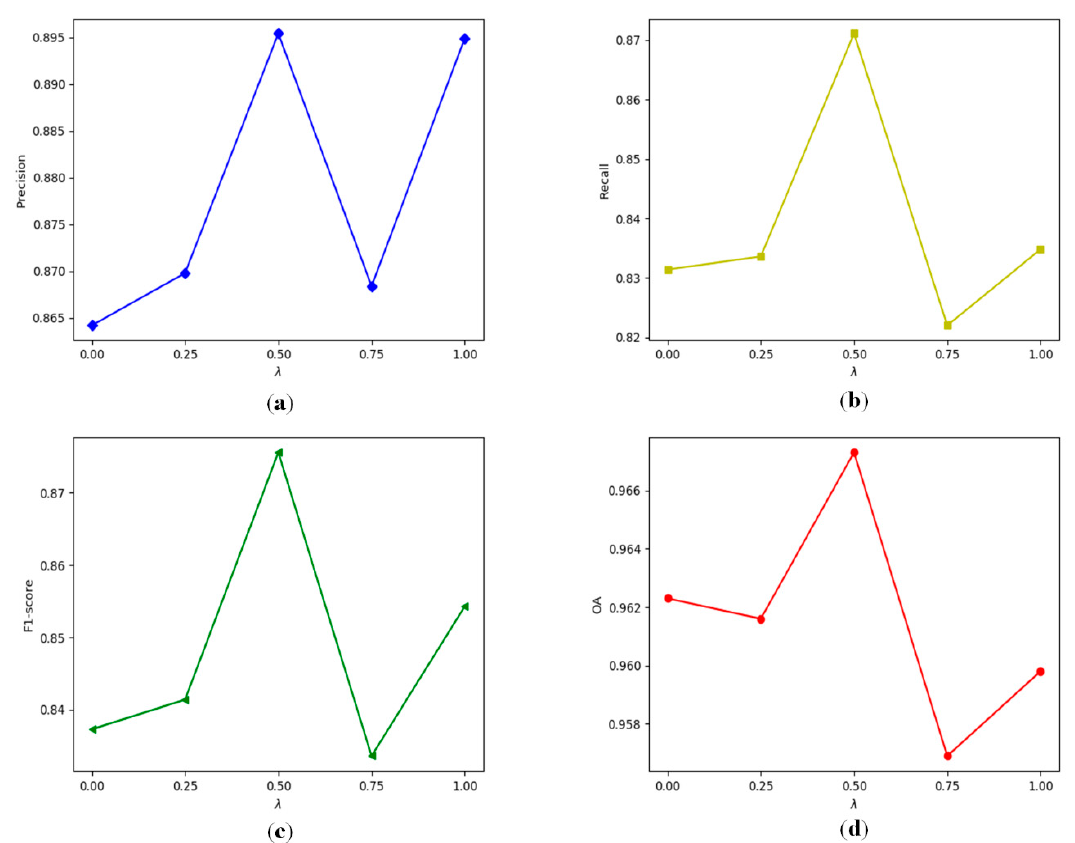
Figure 4. The e ff ects of parameter λ on the accuracy of our CD method: ( a ) the e ff ect of parameter λ on Figure 4. The effects of parameter 𝜆 on the accuracy of our CD method: ( a ) the effect of parameter 𝜆 Precision; ( b ) the e ff ect of parameter λ on Recall; ( c ) the e ff ect of parameter λ on F1-score; ( d ) the e ff ect on Precision; ( b ) the effect of parameter 𝜆 on Recall; ( c ) the effect of parameter 𝜆 on F1-score; ( d ) the of parameter λ on effect of parameter 𝜆 on OA.